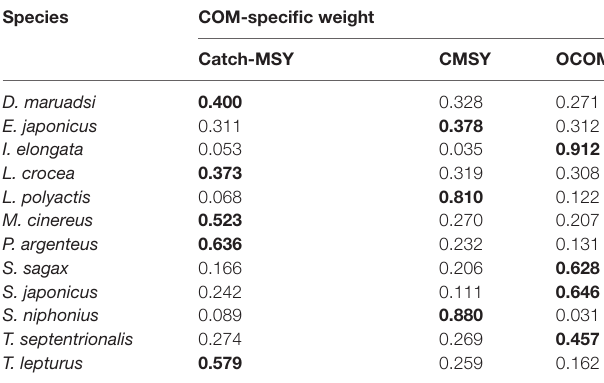
TABLE 3 | Catch-only methods and their weight in calculating weighted means of B and F time series, as well as reference points B MSY and F MSY , for the fisheries in the